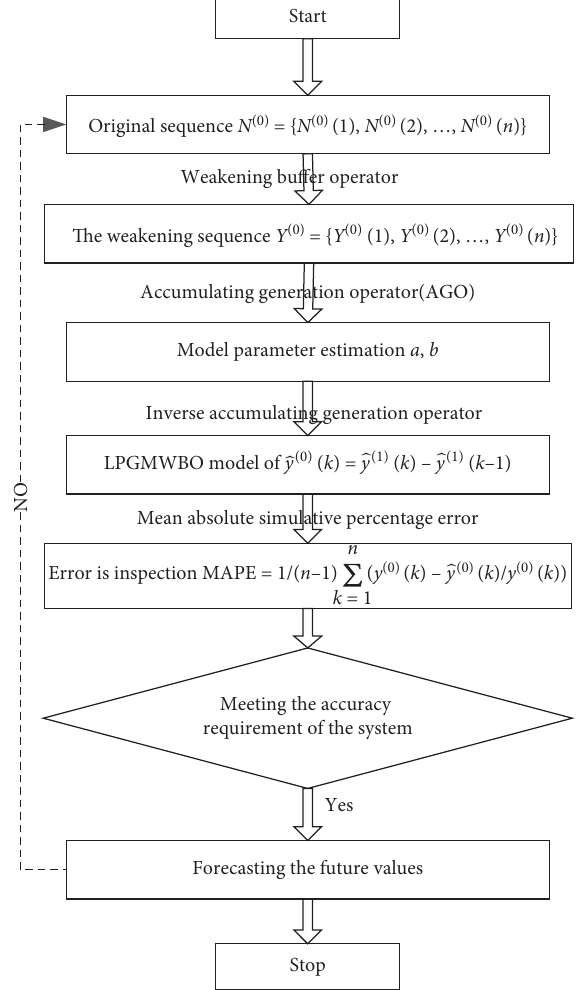
Figure 1: Flowchart of the